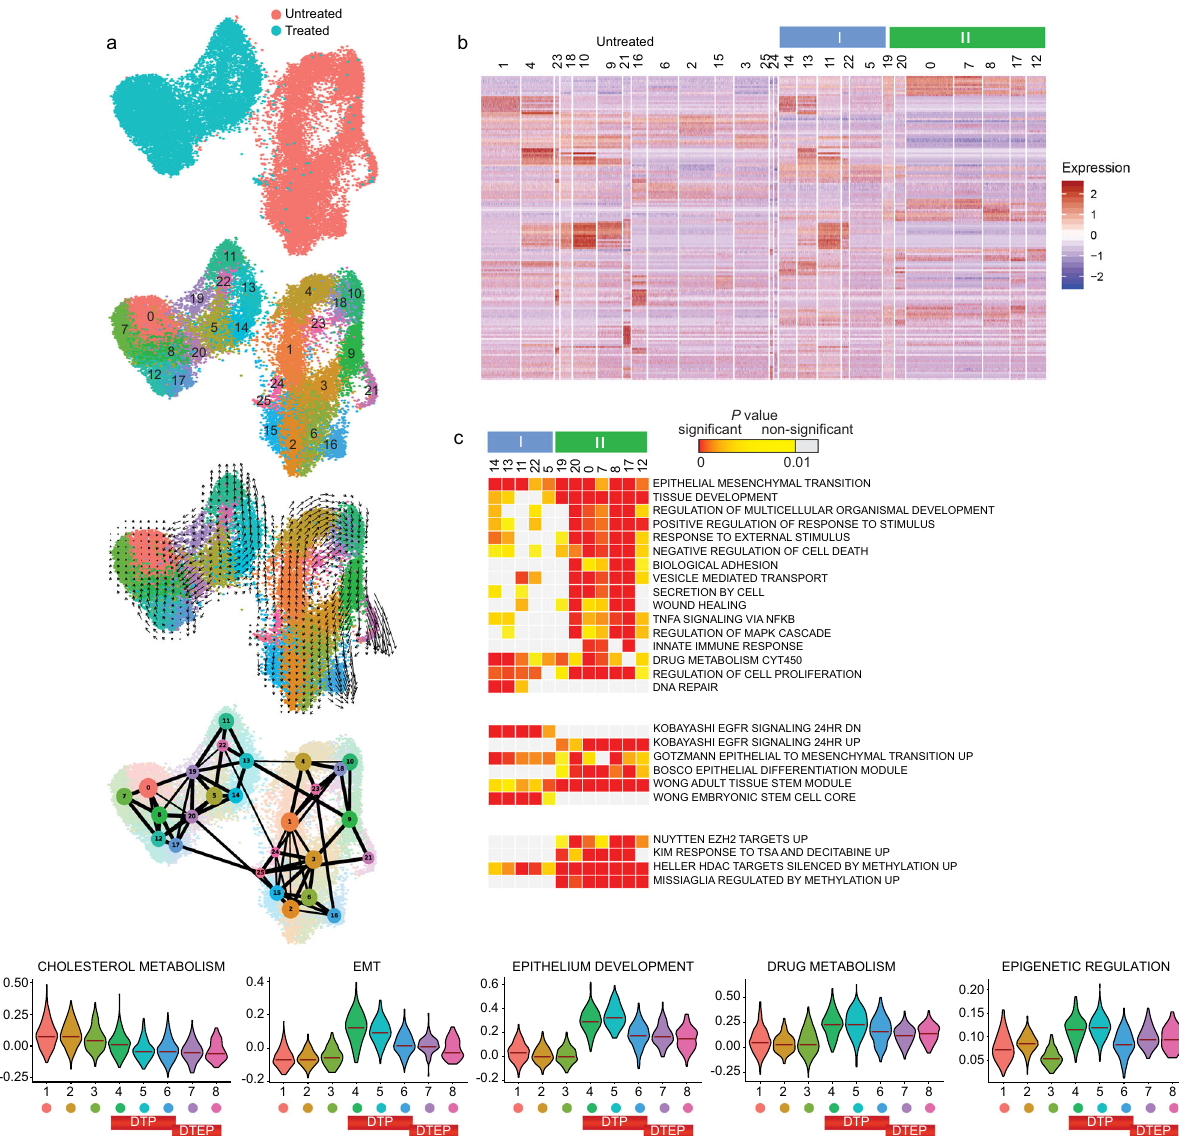
Fig. 4 Drug tolerant cells are highly heterogenous and represent distinct cell subpopulations and cell states. a UMAP representation of two PC9 samples, untreated or treated with erlotinib for 3 days, that were analyzed by 10x Genomics scRNA-seq, colored by clusters, with Velocyto projection, and PAGA graph to identify emerging drug-tolerant subpopulations. Arrows re fl ect the direction in which the nearby cells would travel. PAGA graph is also used to infer trajectory: the size of a circle quanti fi es the number of cells in the cluster, and the line thickness represents the connectivity strength between clusters. b Heatmap of top markers of each cluster. Cluster annotation is as in a . c Enrichment analysis for top cluster markers ( P < 0.05). Top, gene relations to hallmark gene sets or GO BP terms; middle, gene sets associated with CGP datasets; and bottom, epigenetic signatures (MSigDB Collections). Two subpopulations of tolerant cells, I and II, are delineated by blue and green boxes. GO gene sets overlapping with at least 10 markers in one DT cluster, P < 10 − 6 , were included. Most presented CGPs are representative of several similar experiments, where terms with more than 18 markers and P < 10 − 8 at least in one DT cluster, but P > 10 − 4 in any of the cluster of untreated cells were included. Data represents right tail P values, two-sided binomial statistical test, adjusted for multiple testing using Benjamini – Hochberg FDR method. d Violin plots of expression level for gene sets corresponding to top biological processes, hallmarks, and epigenetic perturbations (MSigDB Collections) in cells at different states of transition to tolerance (from Fig. 1d). The median of the data is shown by the horizontal